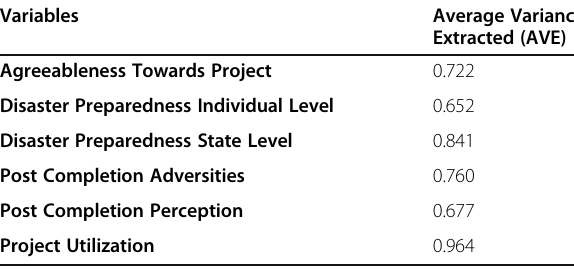
Table 4 Instrument ’ s convergent